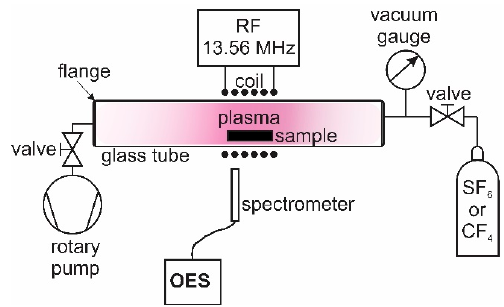
Figure 1. Schematic diagram of the plasma system for sample treatment.